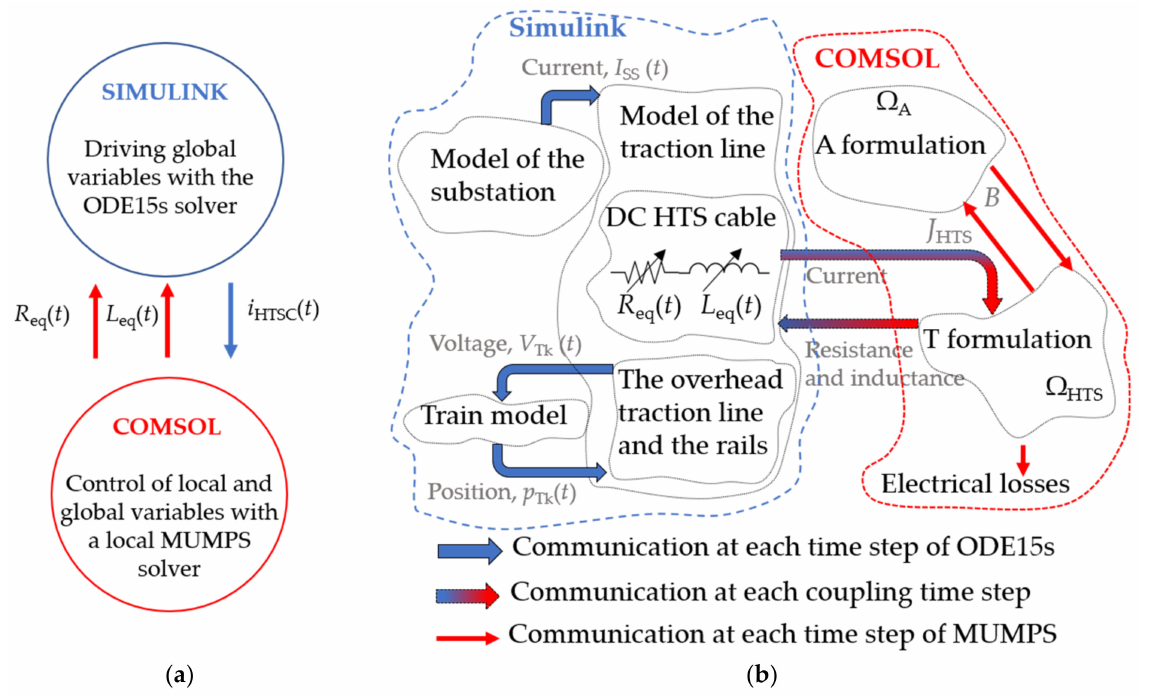
Figure 13. ( a ) Simplified diagram describing the communication between the two software. ( b ) Concep- tual diagram of the coupling between the Simulink and the Comsol FEM software (co-simulation). B is the magnetic flux density, and J HTS is the current density in the superconducting